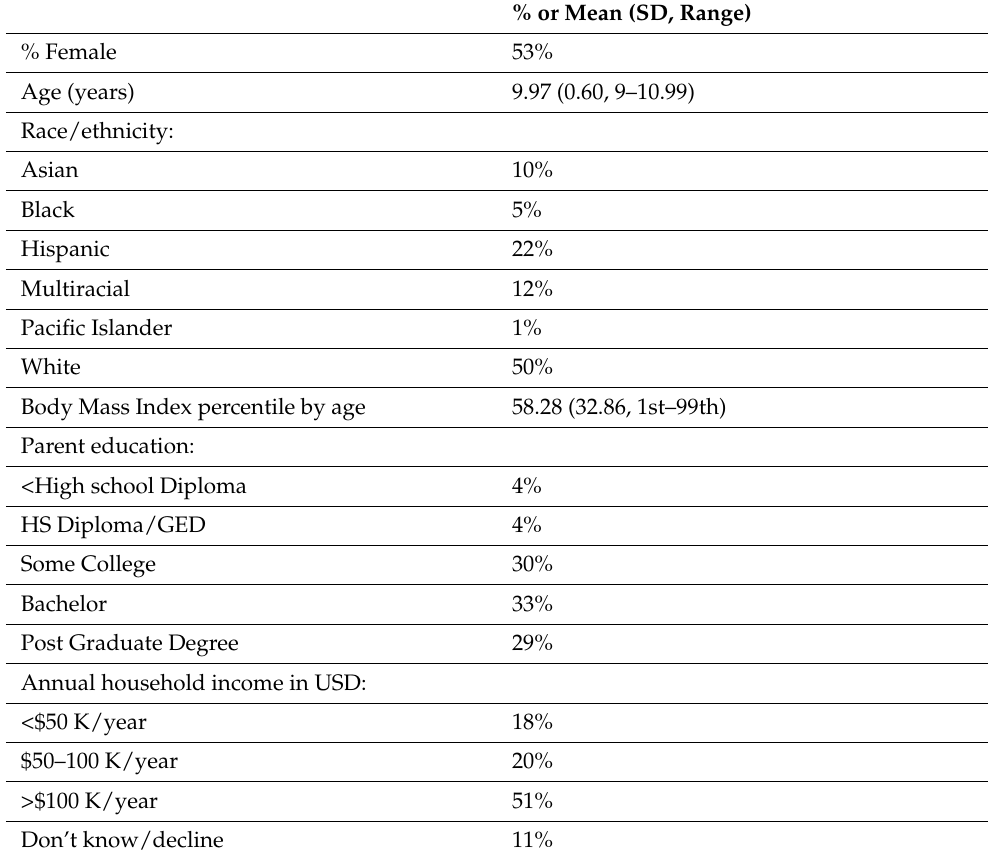
Table 1. ABCD Fitbit substudy participant characteristics (N =